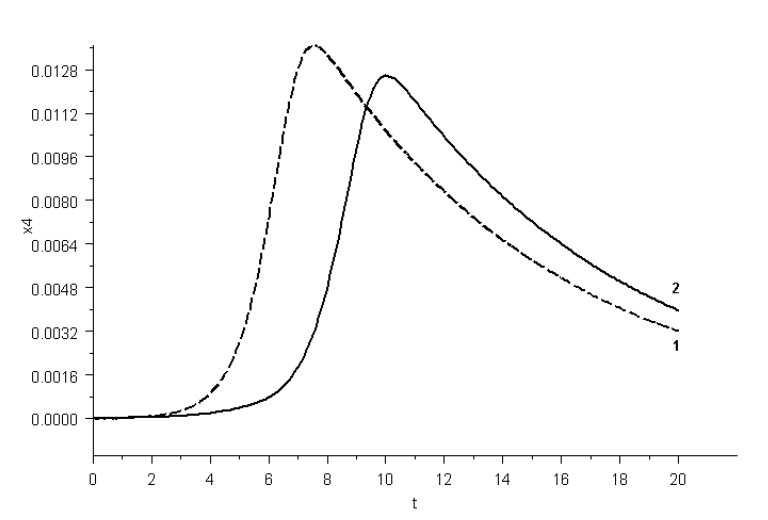
Figure 5. 1—trajectory x 4 for u = 0; 2—computational trajectory x 4